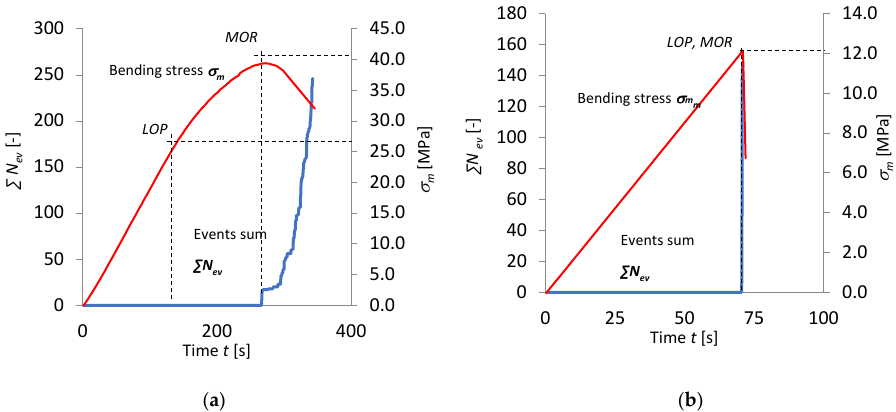
Figure 6. Bending stress σ m and events sum ∑ N ev versus time t for boards of: ( a ) series C R and ( b ) series C T .